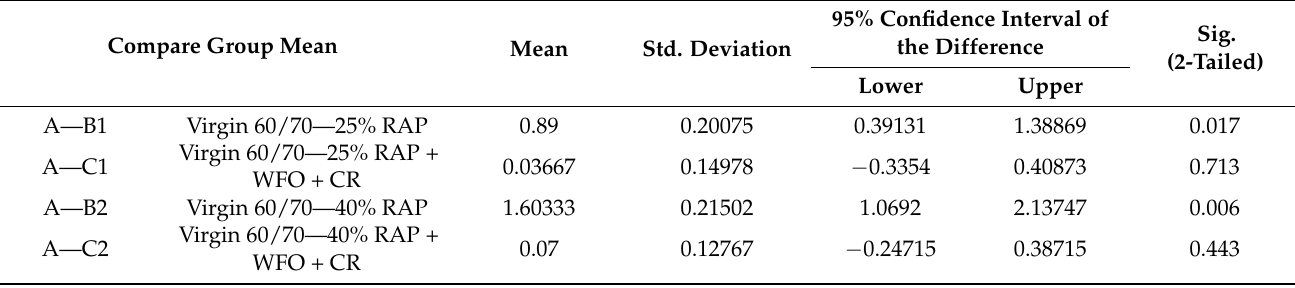
Table 20. The significant difference in the group means for the rutting of the virgin asphalt with RAP and the rejuvenated asphalt mixture at 60 ◦